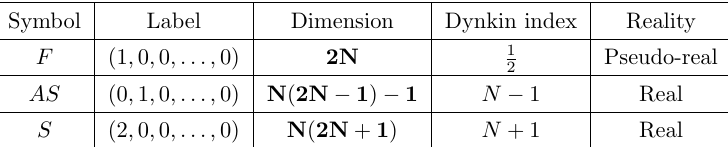
Table 11 . Various group theory data for USp(2 N ) representations associated with tensors with at most two indices. Here the label entry stands for the standard Dynkin label of the representation, and the symbol entry provides the shorthand symbol that will be employed for that representation throughout this article. Additionally, the dimension, Dynkin index and the reality properties of the representation are